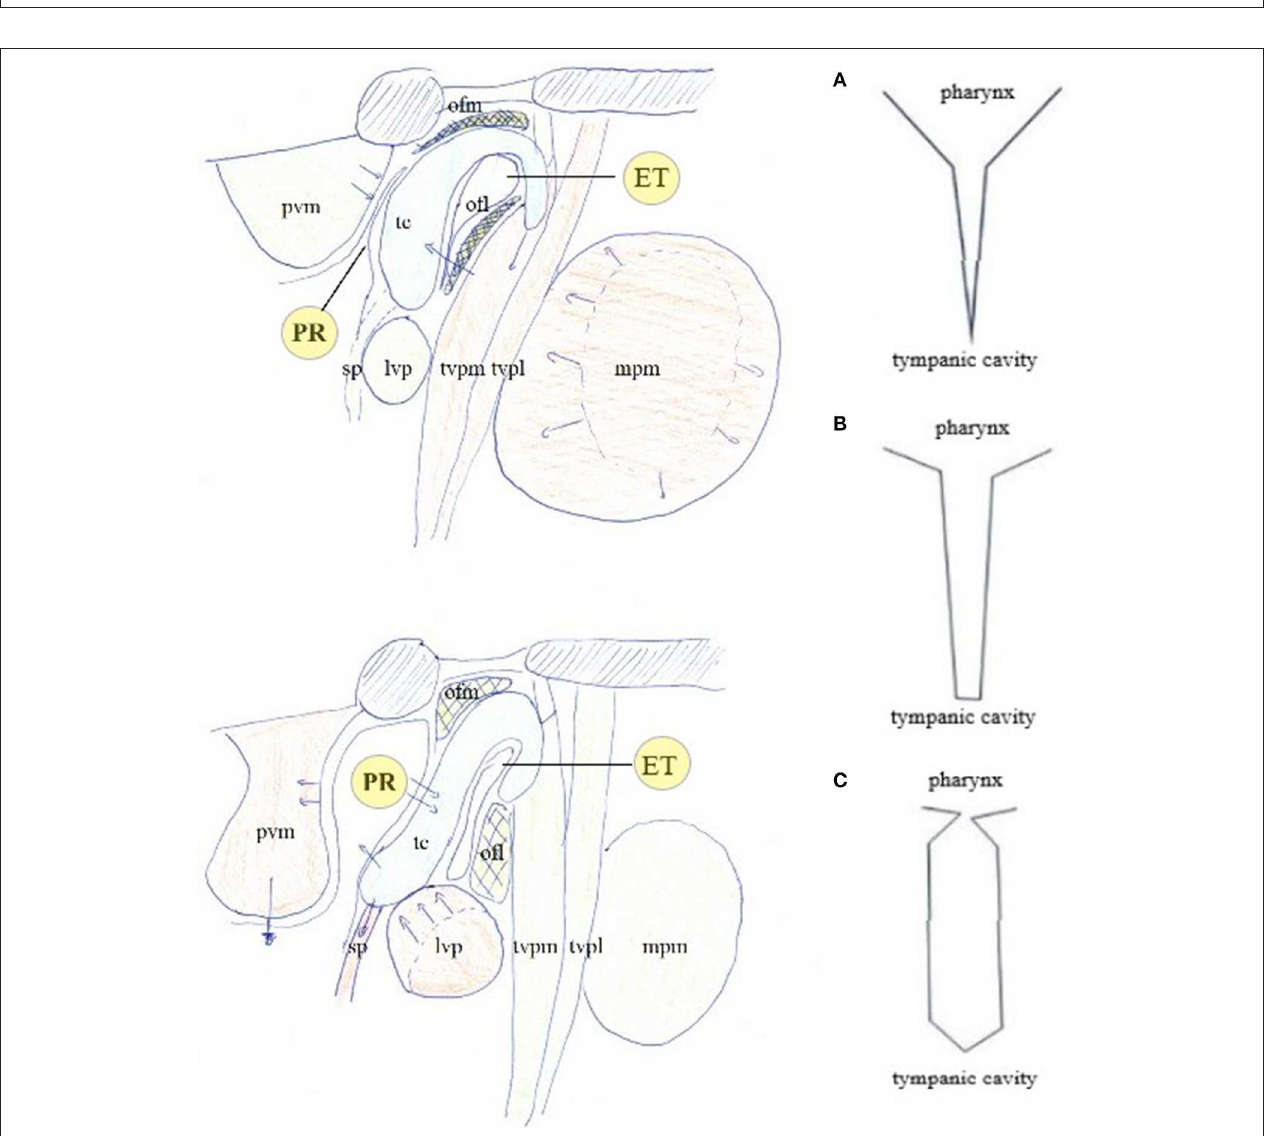
FIGURE 7 | The muscular apparatus modifies the shape of the PR/ET complex. Contraction of trigeminally innervated muscles with relaxation of vagally/cervical plexus innervated muscles closes PR/ET complex (upper left); contraction of vagally/cervical plexus innervated muscles with relaxation of trigeminally innervated muscles opens PR/ET complex (lower left) (A) PR/ET closed; (B) theoretical neutral position; (C) PR/ET opened. Pvm, prevertebral muscles (cervical plexus); PR, pharyngeal recess; tc, tubal cartilage; sp, salpingopharyngeus muscle (X); lvp, levator veli palatini muscle (X); ofl, lateral Ostmann’s fat pad; ofm, medial Ostmann’s fat pad; tvpm/tvpl, medial and lateral layer of tensor veli palatini muscle (V); ET, Eustachian tube lumen; mpm, medial pterygoid muscle (V).